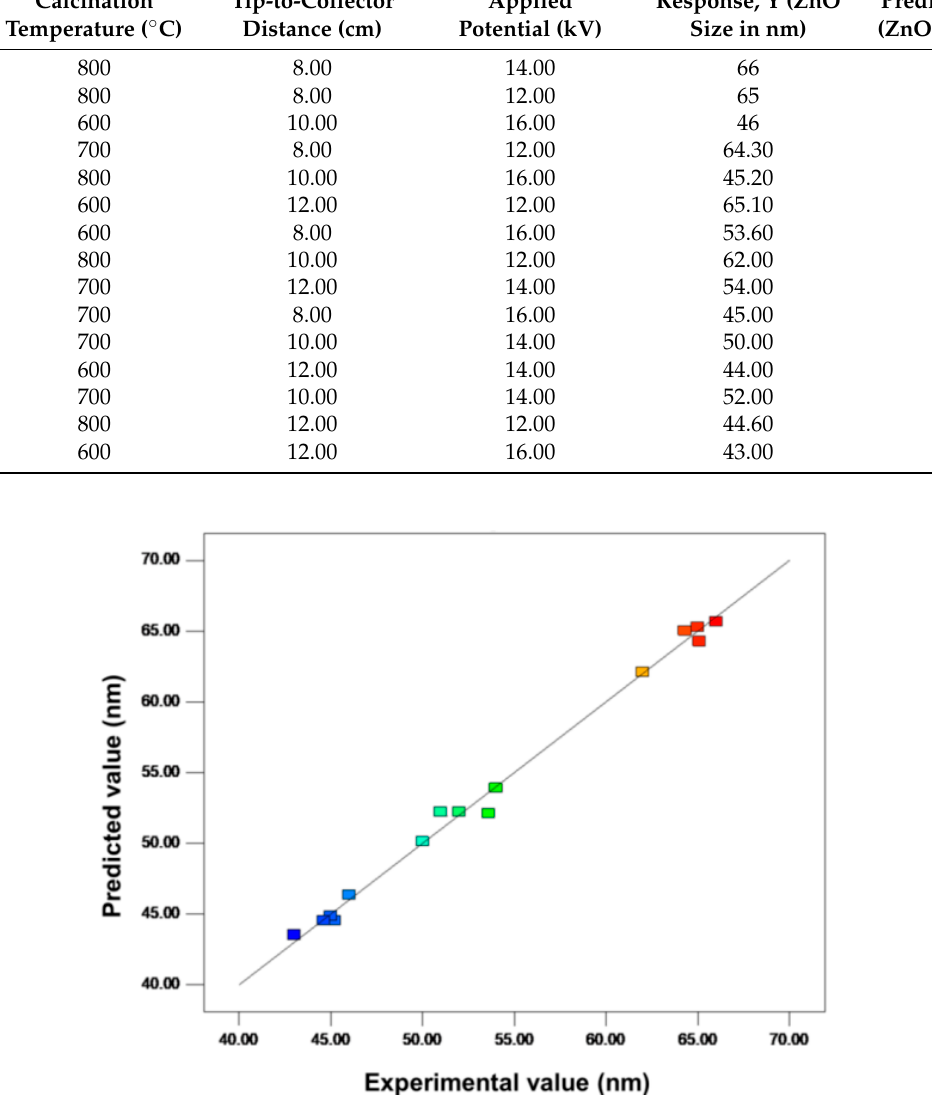
Figure 2. Plot of the model-predicted versus observed response of ZnO particle average size.